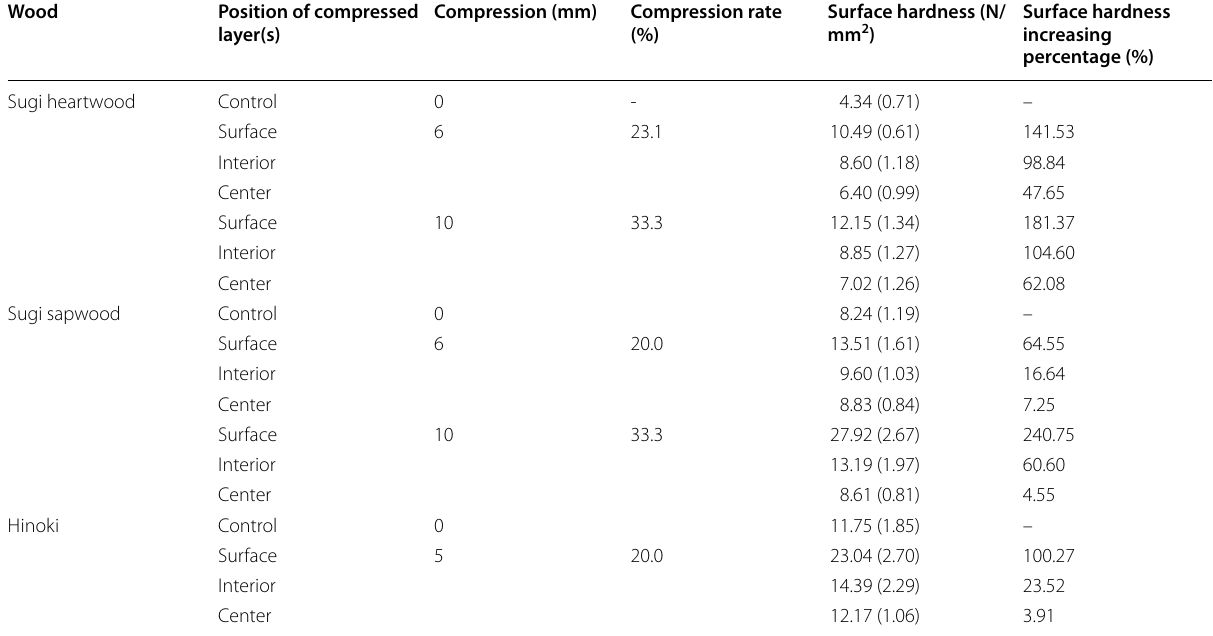
Value in () is standard deviation of six replicates under each condition